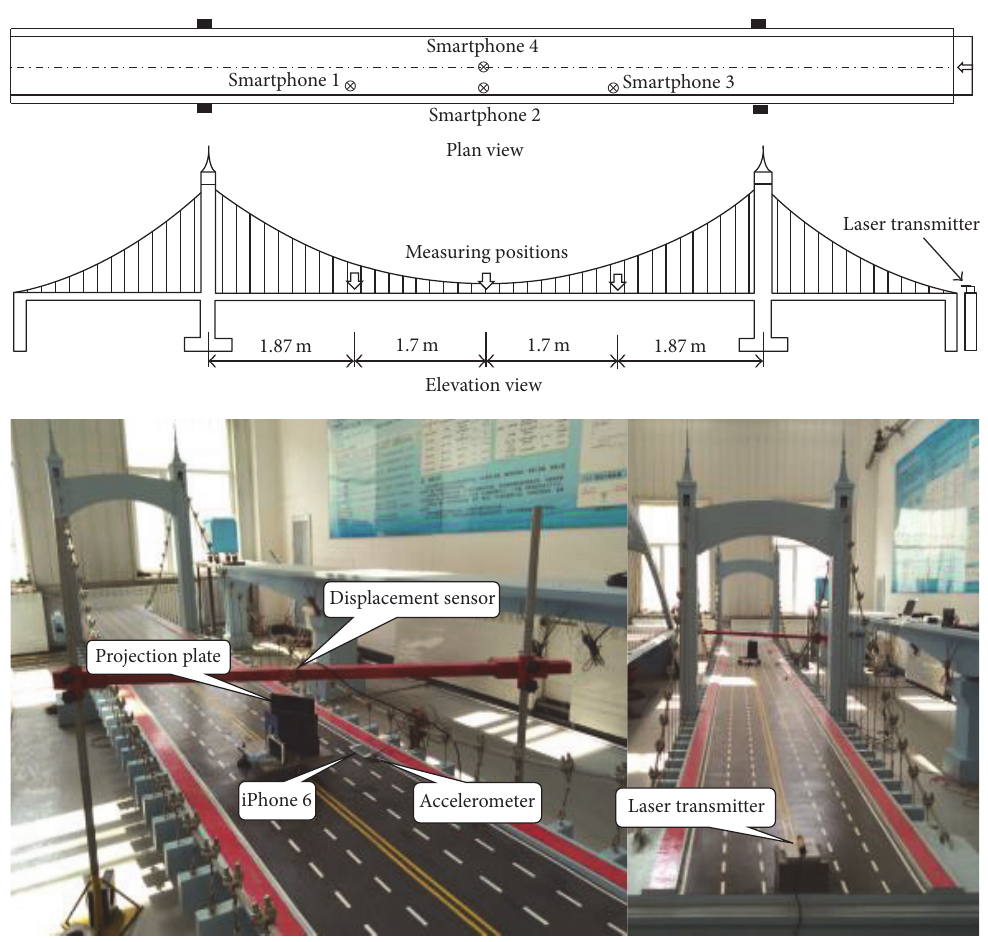
Figure 11: Setup of experiment.